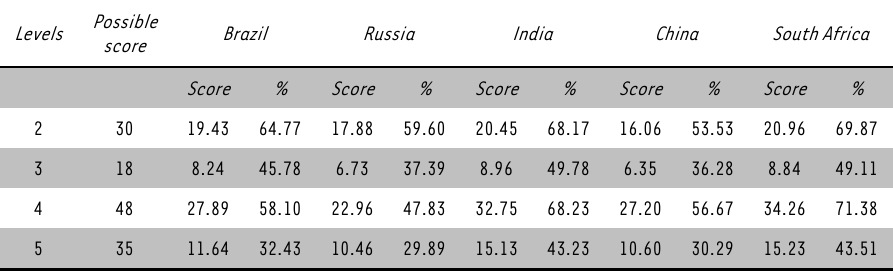
TABLE 3: Element 1 - Services and role Possible Levels score